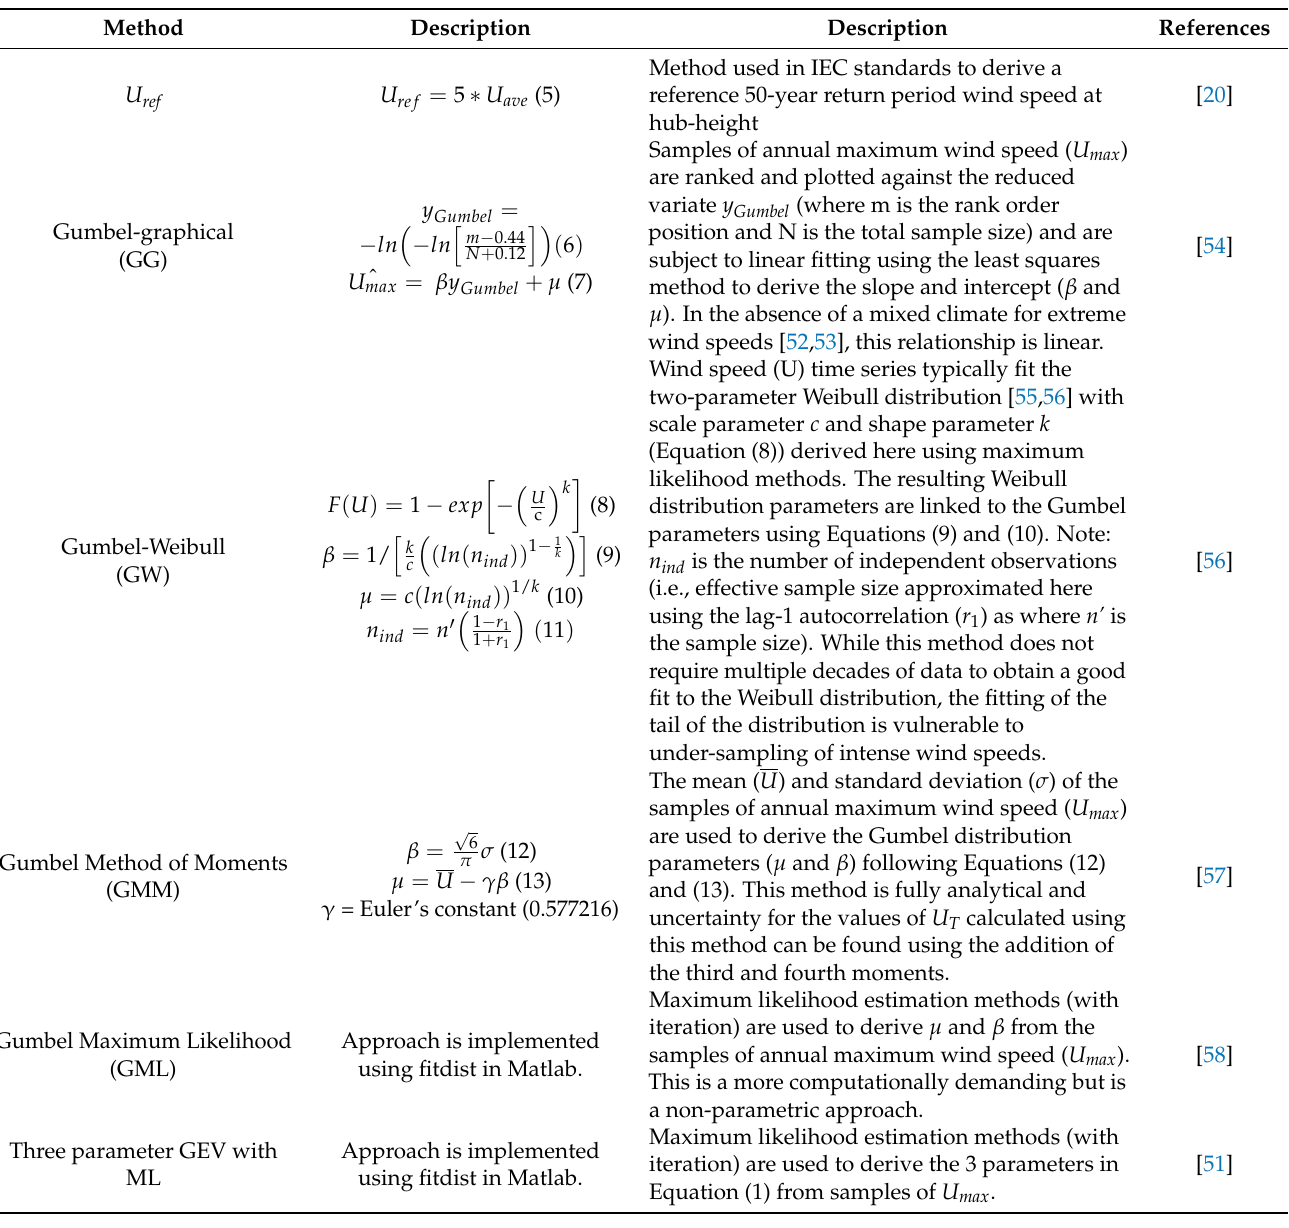
Table 3. Method employed here to compute extreme wind